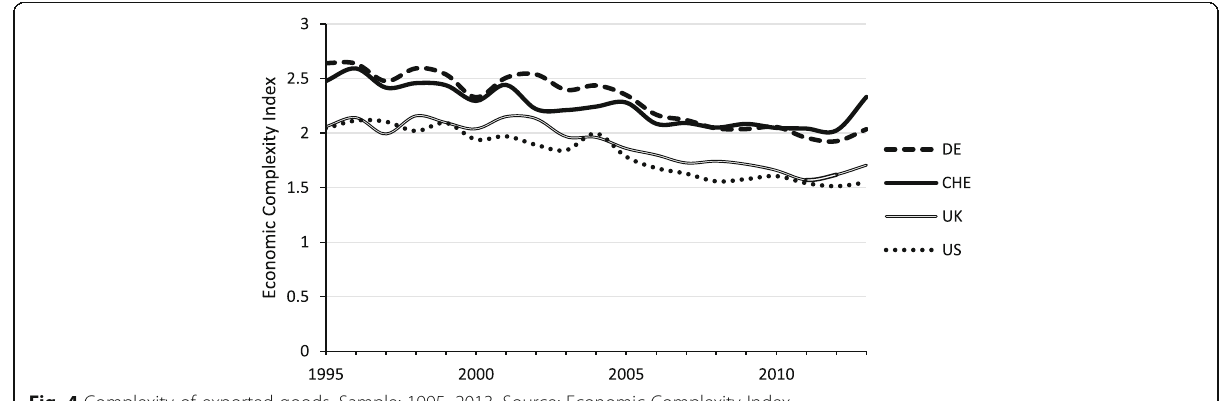
Fig. 4 Complexity of exported goods. Sample: 1995 – 2013, Source: Economic Complexity